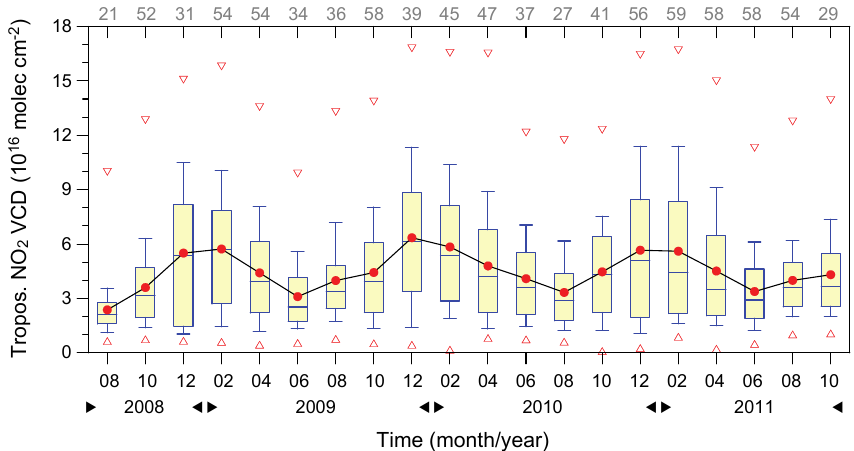
Fig. 6. Time series of the tropospheric NO 2 vertical column density (VCD) over Beijing from August 2008 to September 2011. Given are the bimonthly mean values for each two sequential months between August 2008 and August 2011. Lower (upper) error bars, yellow boxes and lower (upper) triangles are 10th (90th), 25th (75th) percentiles and minimums (maximums) of the data grouped in each interval, respectively. Hyphens inside the boxes are the medians, and red circles the mean values. The numbers of integrated sampling days for each data point are labeled at the top axis.